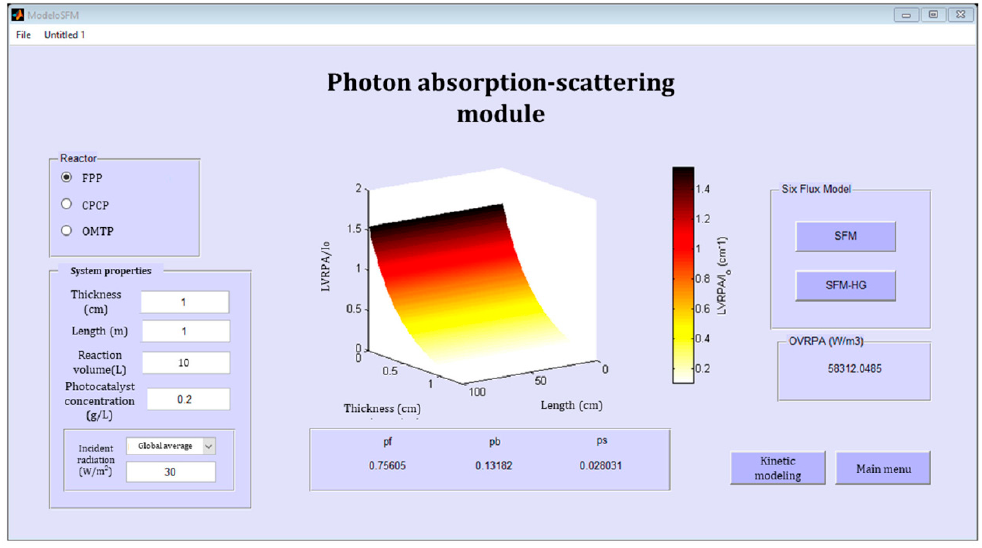
Figure 9. A radiation field simulation of a flat plate photoreactor (FPP) with SFM-HG. The window of PHOTOREAC software [85].